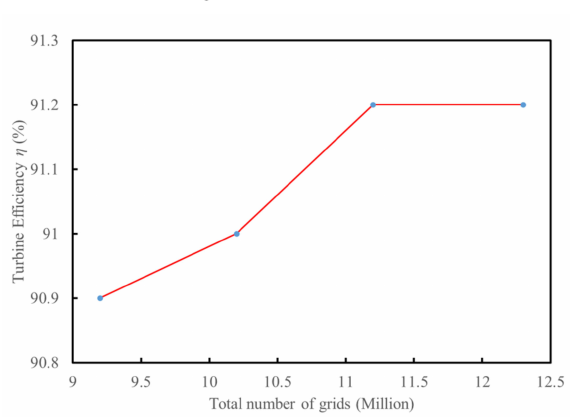
Figure 3. Clearance grids.